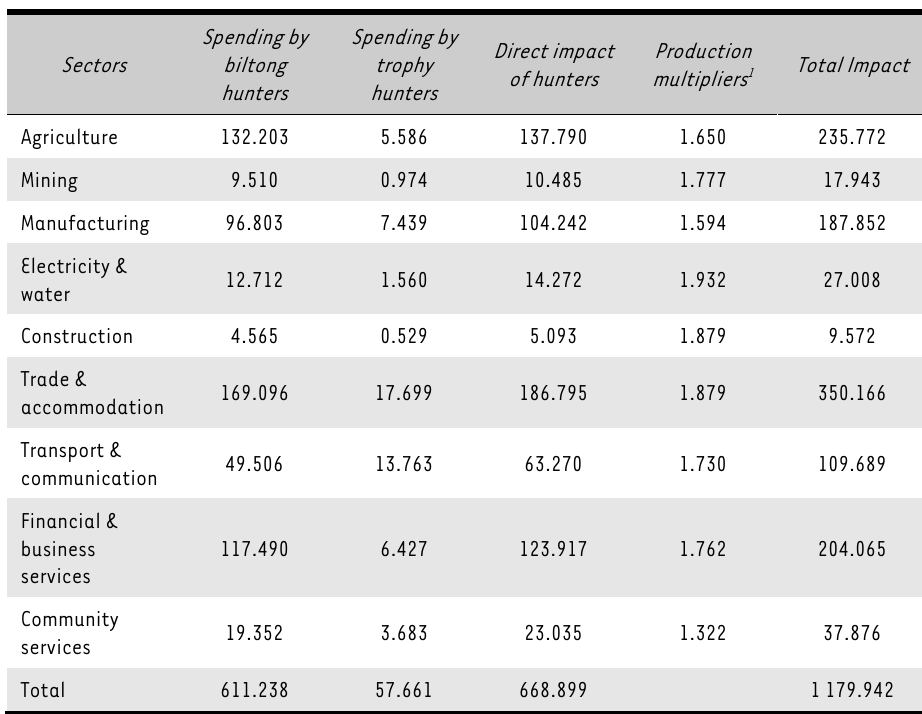
Total impact of hunter spending in the Limpopo Province on regional production (ZAR millions, 2006